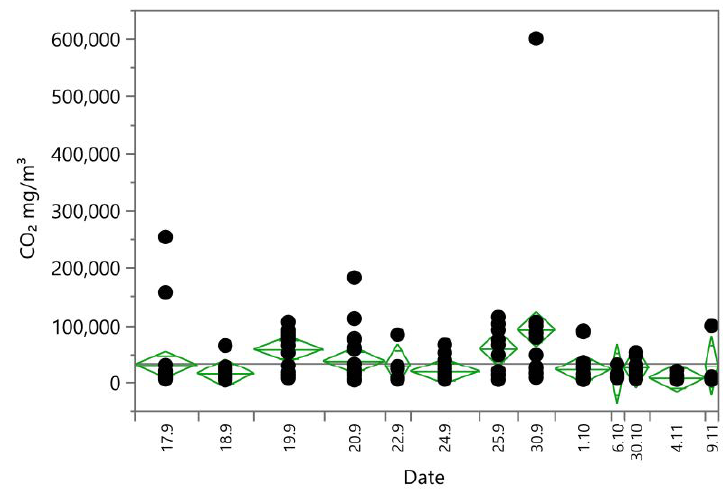
Figure 4. Analysis of CO 2 variability with the influence of the date.